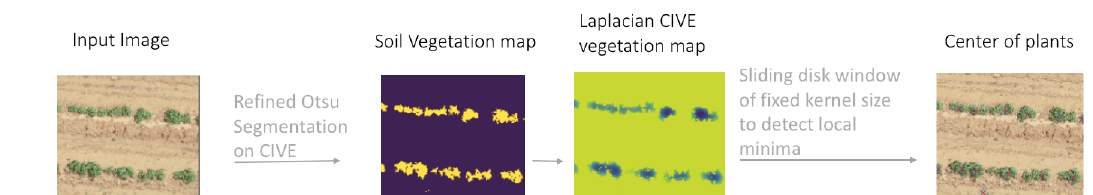
Figure 5. Computer vision based plant detection framework. A CIVE vegetation index is computed from a UAV RGB image before applying Otsu thresholding to discriminate pixels belonging to vegetation and soil. Laplacian filtering is applied to a soil masked CIVE map and, finally, a disk window is slid over this latest to extract local minima, corresponding to the center of the